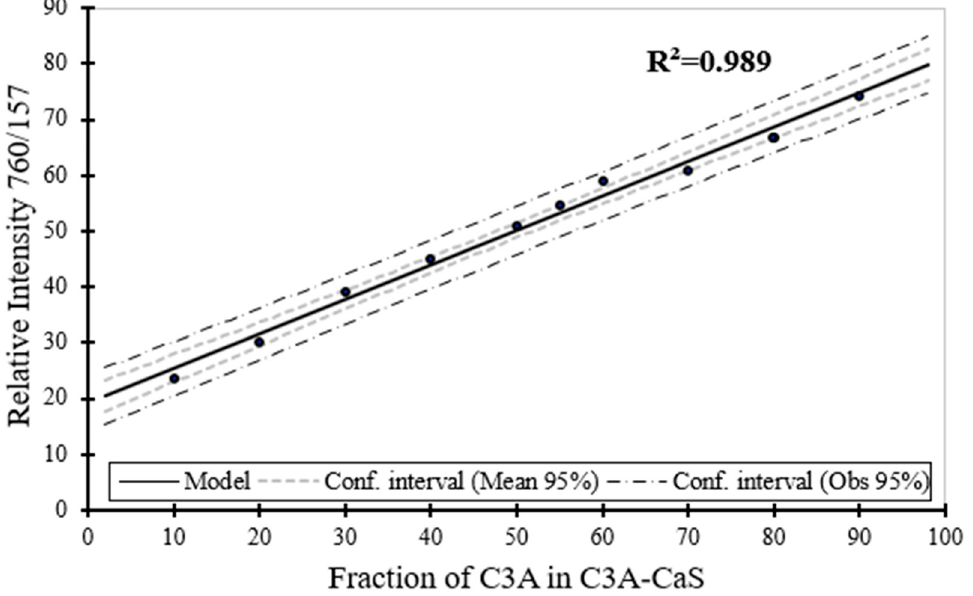
Figure 17. Raman spectroscopy estimation for the phase content (wt. %) for MA as a function of the phase content of MA in C3A–CaS sample.